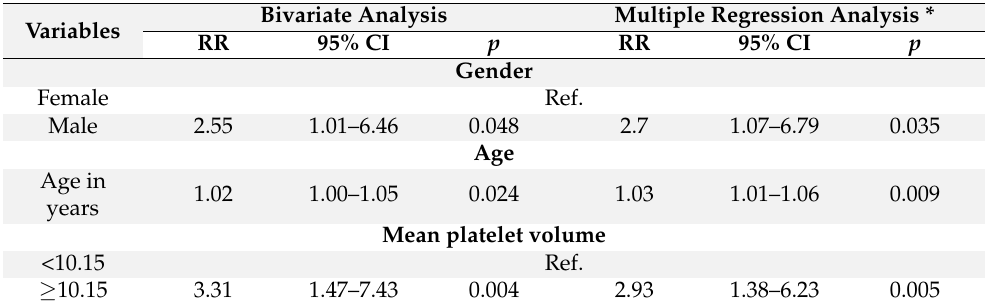
Table 4. Association between MPV and severity of SARS-CoV-2 infection. (Poisson family generalized linear regression model with log link and robust